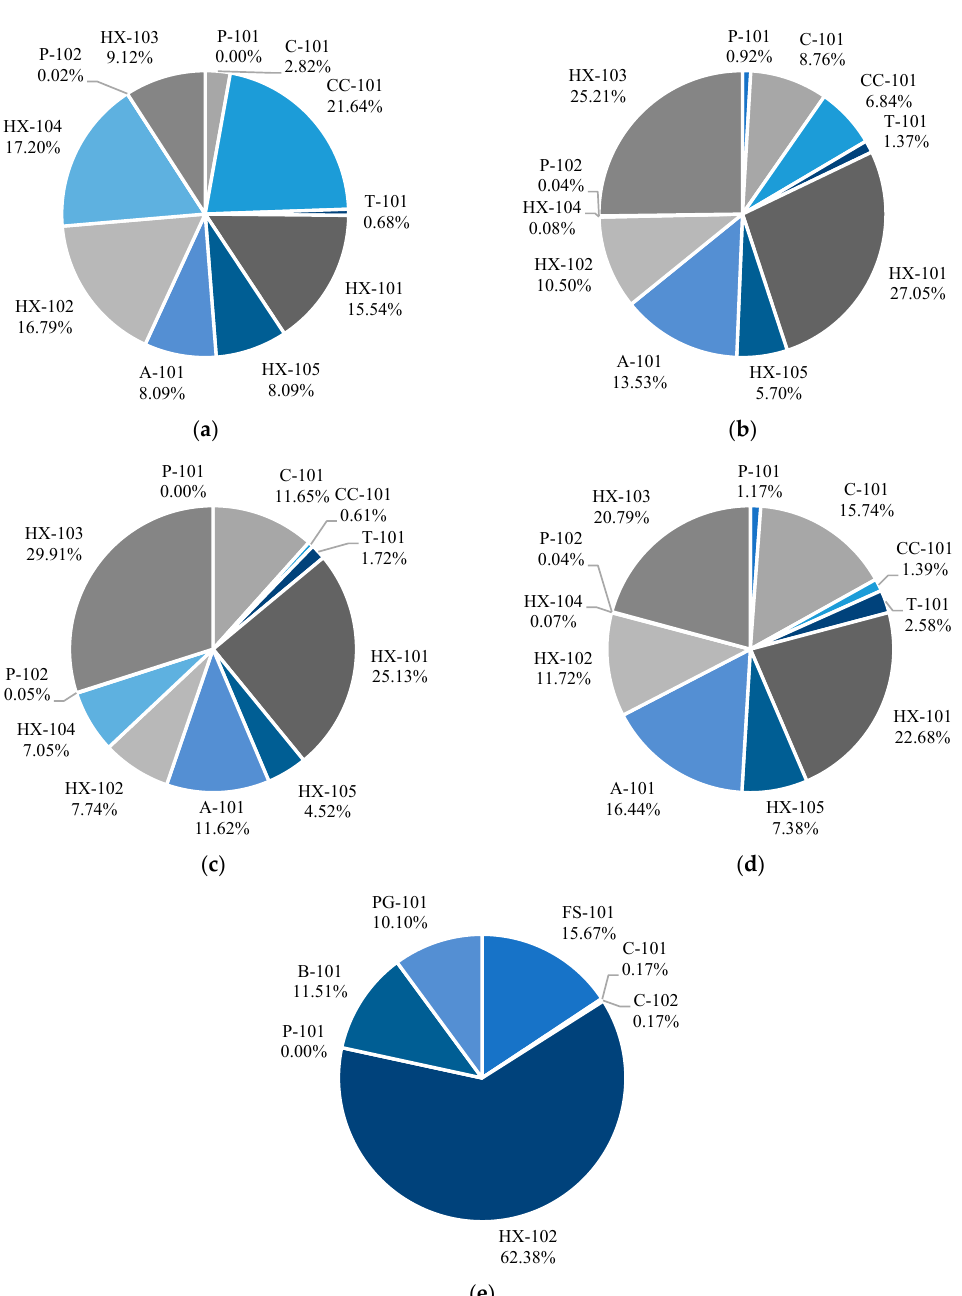
Figure 5. Comparison of ( a ) Total investment cost of the plant and ( b ) Exergy destruction, invest- ment, and O&M cost rates of the CCHP system based on different fuels.